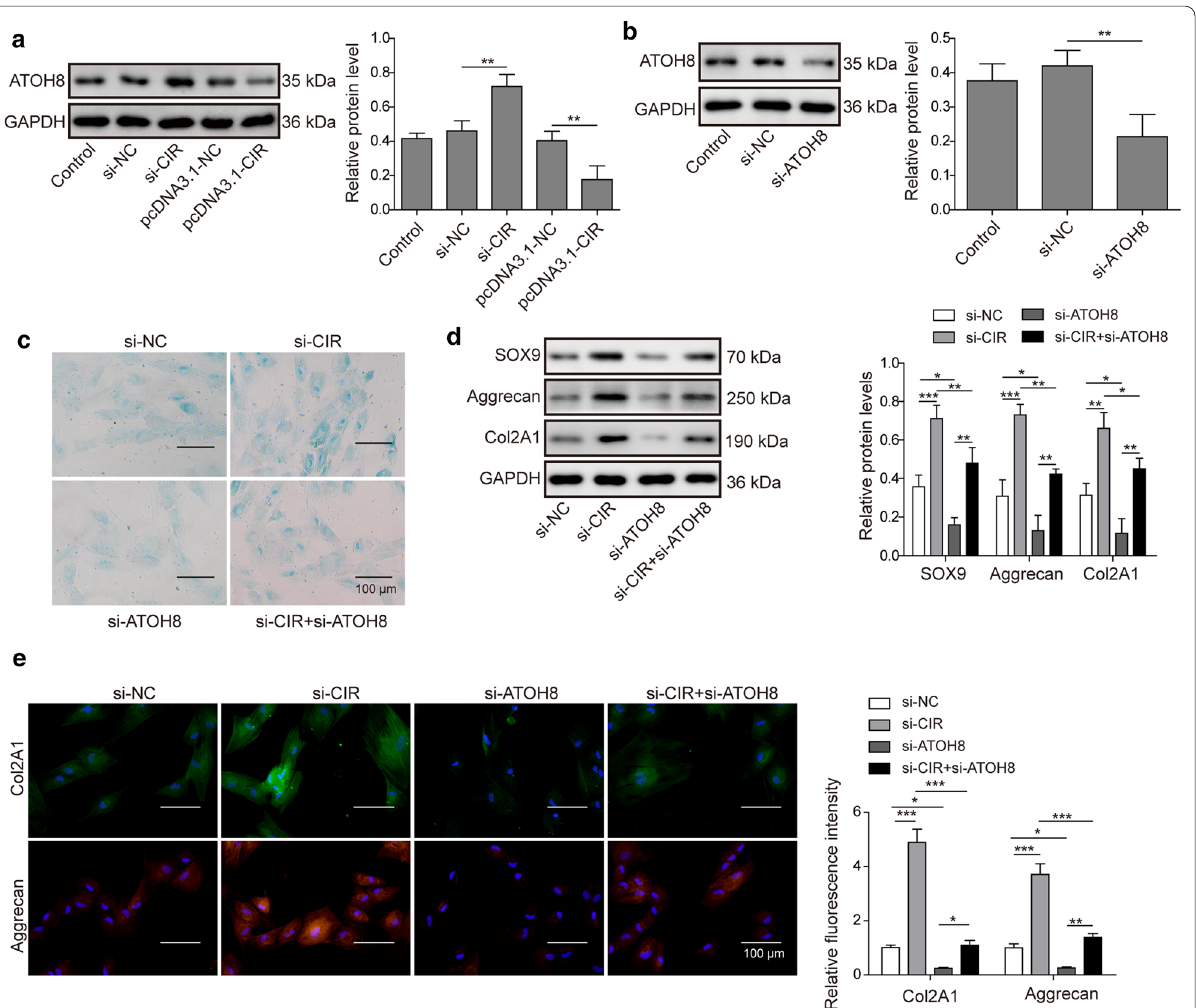
Fig. 6 LncRNA CIR inhibits chondrogenic differentiation by epigenetically inhibiting ATOH8. a qRT‑PCR analysis of ATOH8 mRNA levels in transfected cells. b Western blot analysis of ATOH8 protein levels in transfected cells. c Alcian blue staining to analyze chondrogenic differentiation of hUC‑MSCs transfected with different constructs. d Western blot analysis of expression levels of SOX9, Aggrecan, and Col2A1 in transfected cells. e Immunostaining analysis of levels of Col2A1 and Aggrecan in transfected cells.